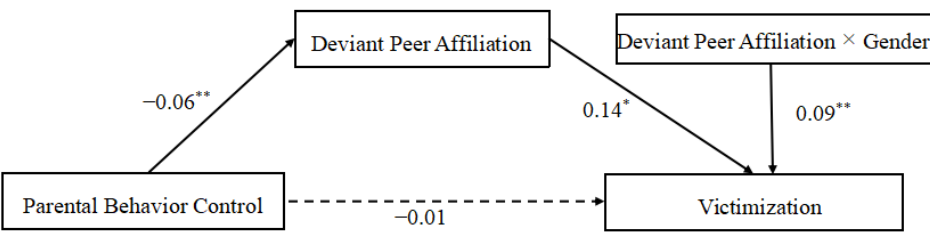
Figure 4. Deviant peer affiliation as a moderated mediator between parental behavioral control and victimization. Note. * p < 0.05, ** p <